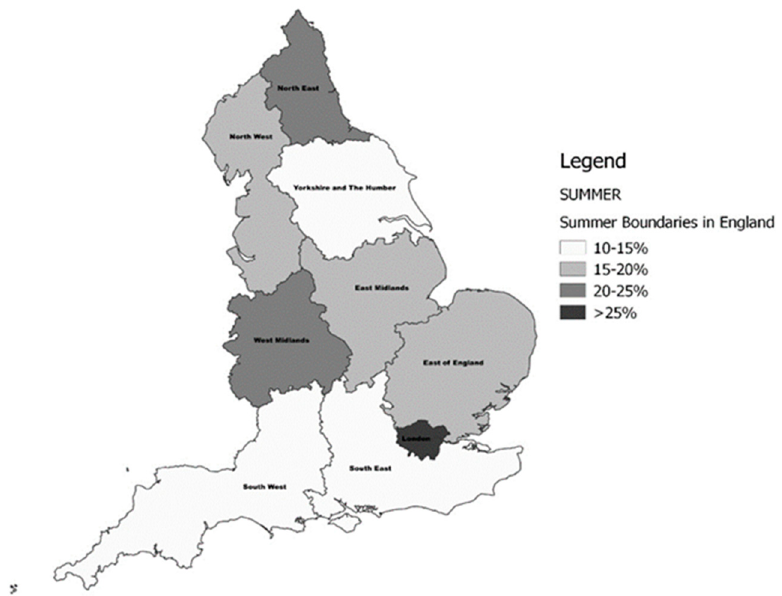
Figure 2. The prevalence of vitamin D deficiency (Institute of Medicine (IOM) <30 nmol/L) in English regions during the Summer period.